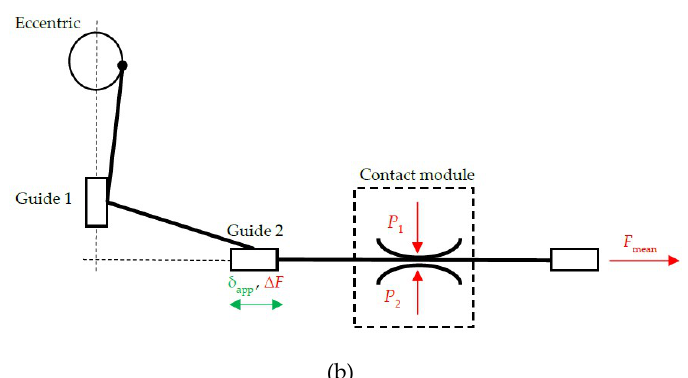
Figure 3. ( a ) Developed fretting wear and fretting fatigue tribometer for thin steel wires. Combined fretting wear and fatigue configuration; ( b ) schematic of the fretting fatigue configuration.